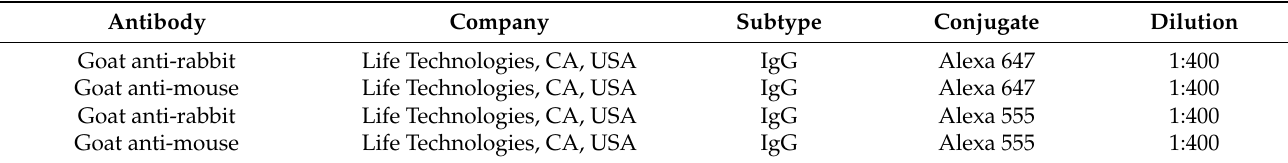
Table 2. List of secondary antibodies used for immunofluorescent